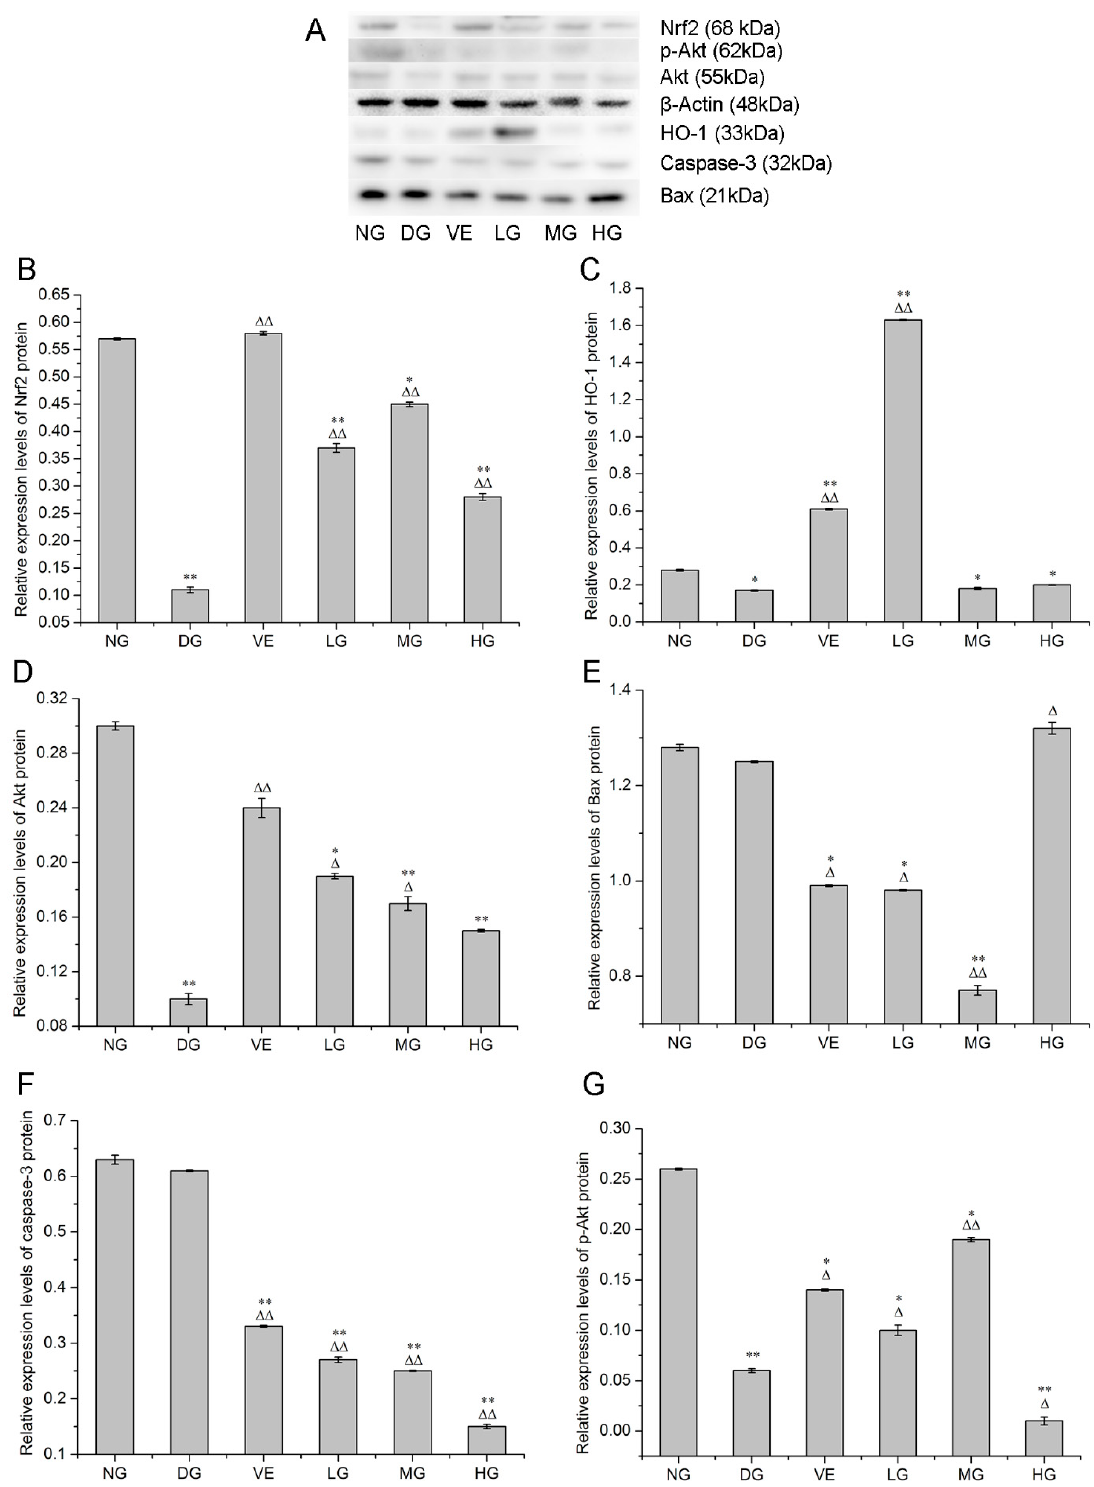
Figure 4. Effect of Athyrium multidentatum (Doll.) Ching (AMC) polysaccharides on ( A ) Nrf2 , ( B ) HO- 1 , ( C ) PI3K , ( D ) Akt , ( E ) FOXO3a , ( F ) Bcl-2 , ( G ) Bax , ( H ) caspase-3 gene expression in mouse liver (n = 6). * p < 0.05, ** p < 0.01, compared with the normal group (NG); ∆ p < 0.05, ∆∆ p < 0.01, compared with the model group (DG).